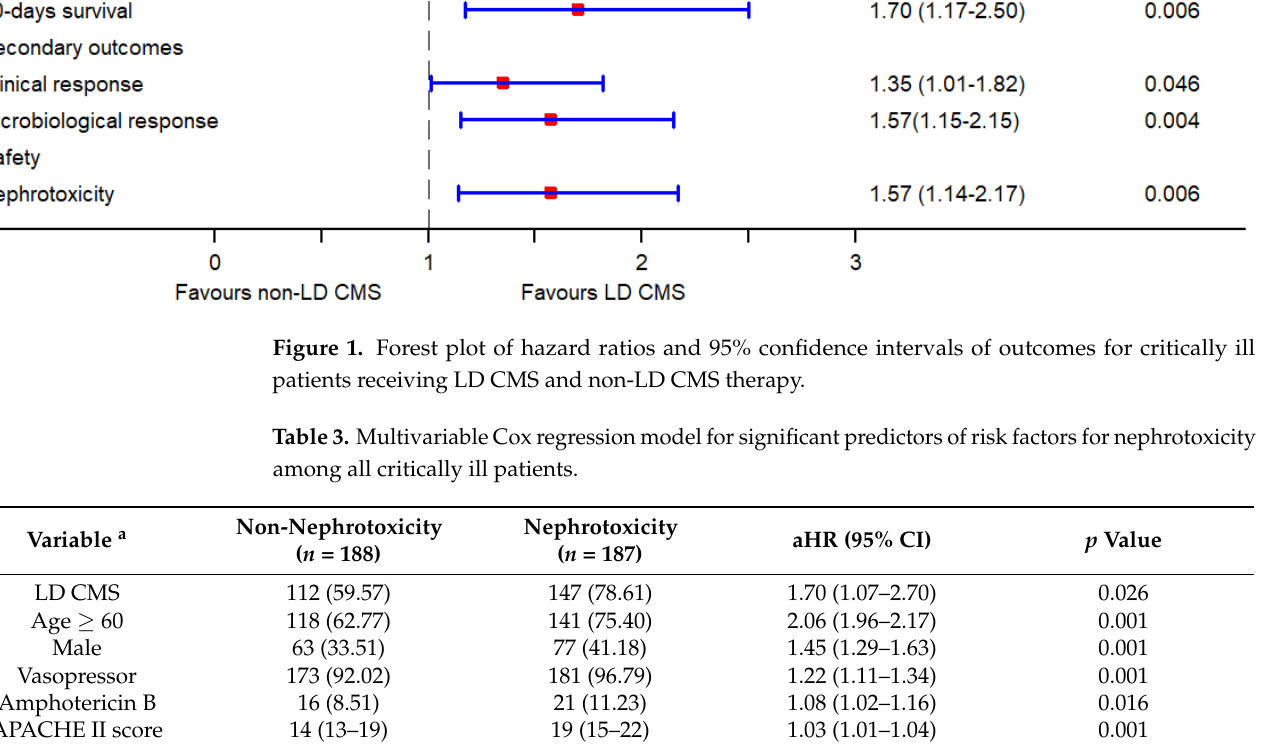
Table 3. Multivariable Cox regression model for significant predictors of risk factors for nephrotox- icity among all critically ill patients.